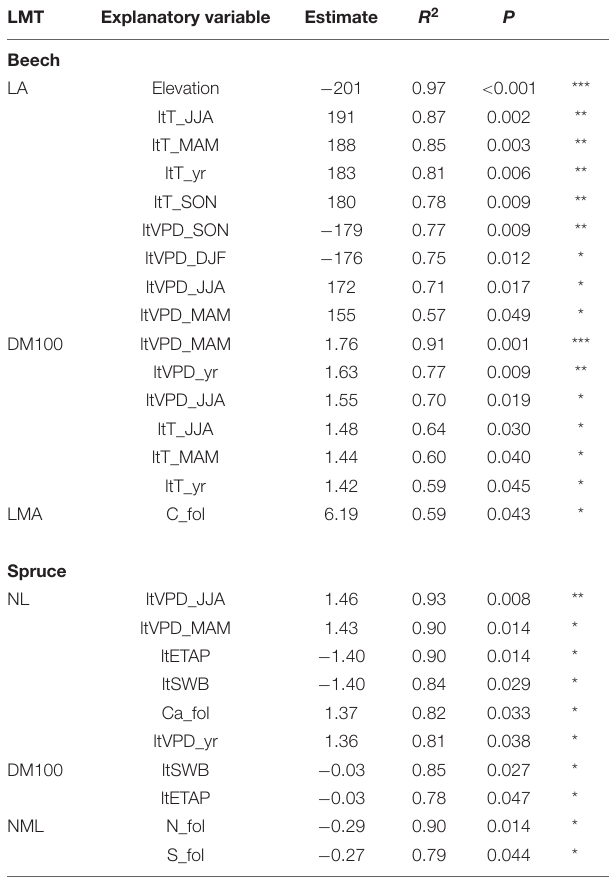
TABLE 5 | Spatial drivers of leaf morphological trait (LMT) variation. LMT Explanatory variable